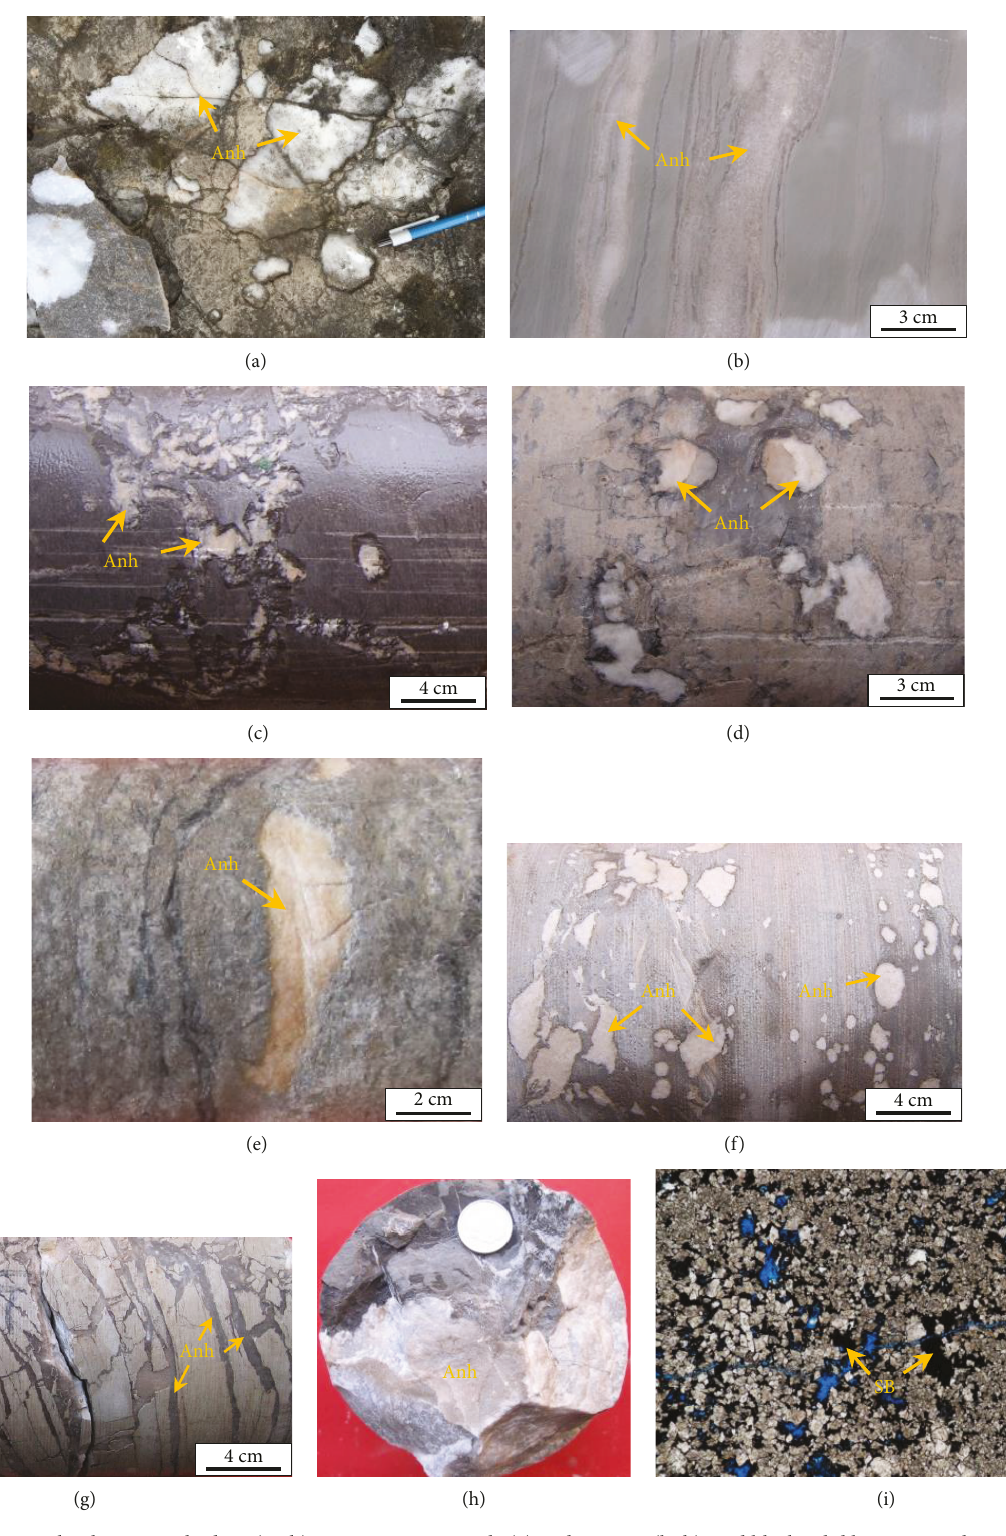
Figure 4: Photographs showing anhydrite (Anh) in an outcrop sample (a) and in cores (b – h), and black solid bitumen in thin section (i). (a) Outcrop JST, T f 4 , anhydrite nodules in dolostone. (b) Well HB1, 4847.6m, T 1 (second member of the Jialingjiang Formation), anhydrite nodules in dolostone. (d) Well MB6, 4015.9m, T limestone. (e) Well XHC1, 5468.2m, T f 1 , anhydrite nodules in dolostone. (f) Well DW2, 4750.7 m, T 1